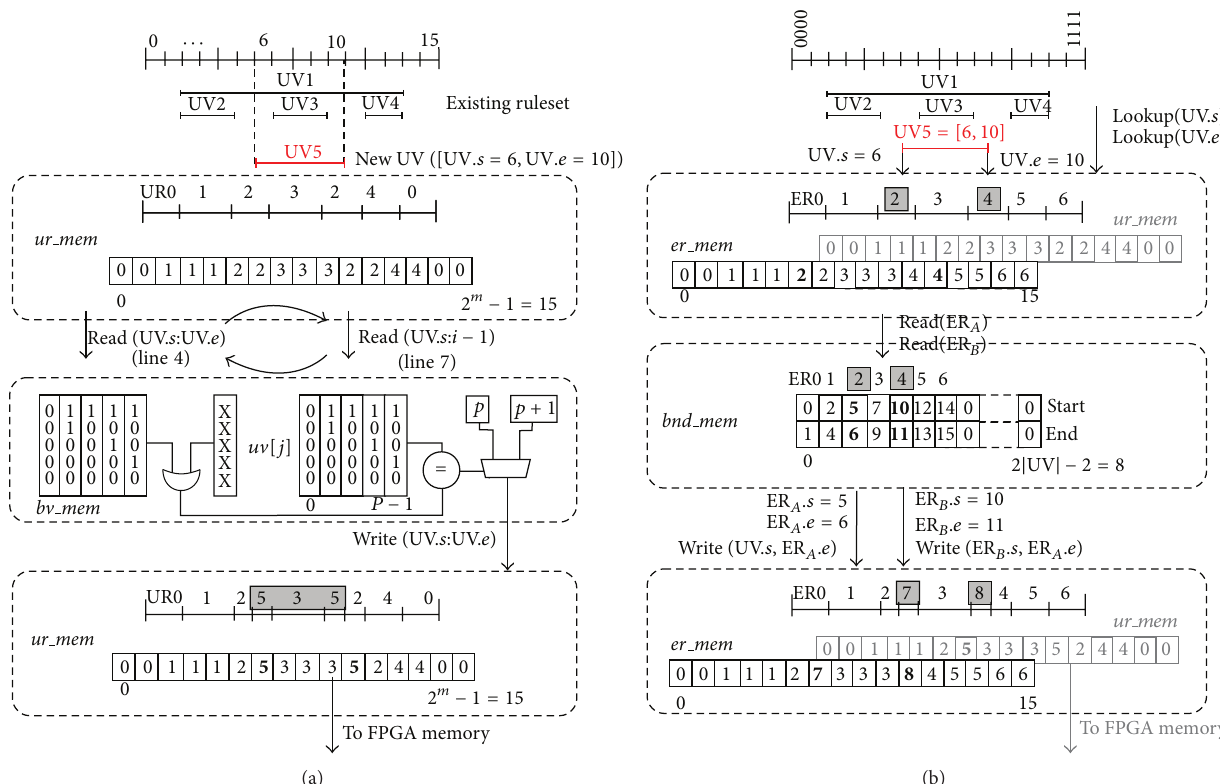
Figure 17: Incremental updating: (a) original architecture for updating of DIR lookup schemes and (b) proposed updating architecture.